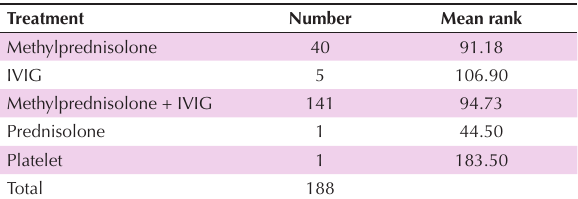
Table 4. Comparison of the duration of hospitalization based on type of treatment (Kruskal-Wallis test)